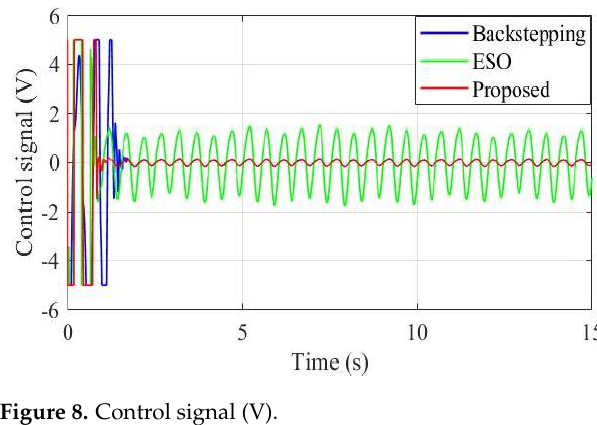
Figure 7. Relative tire force.